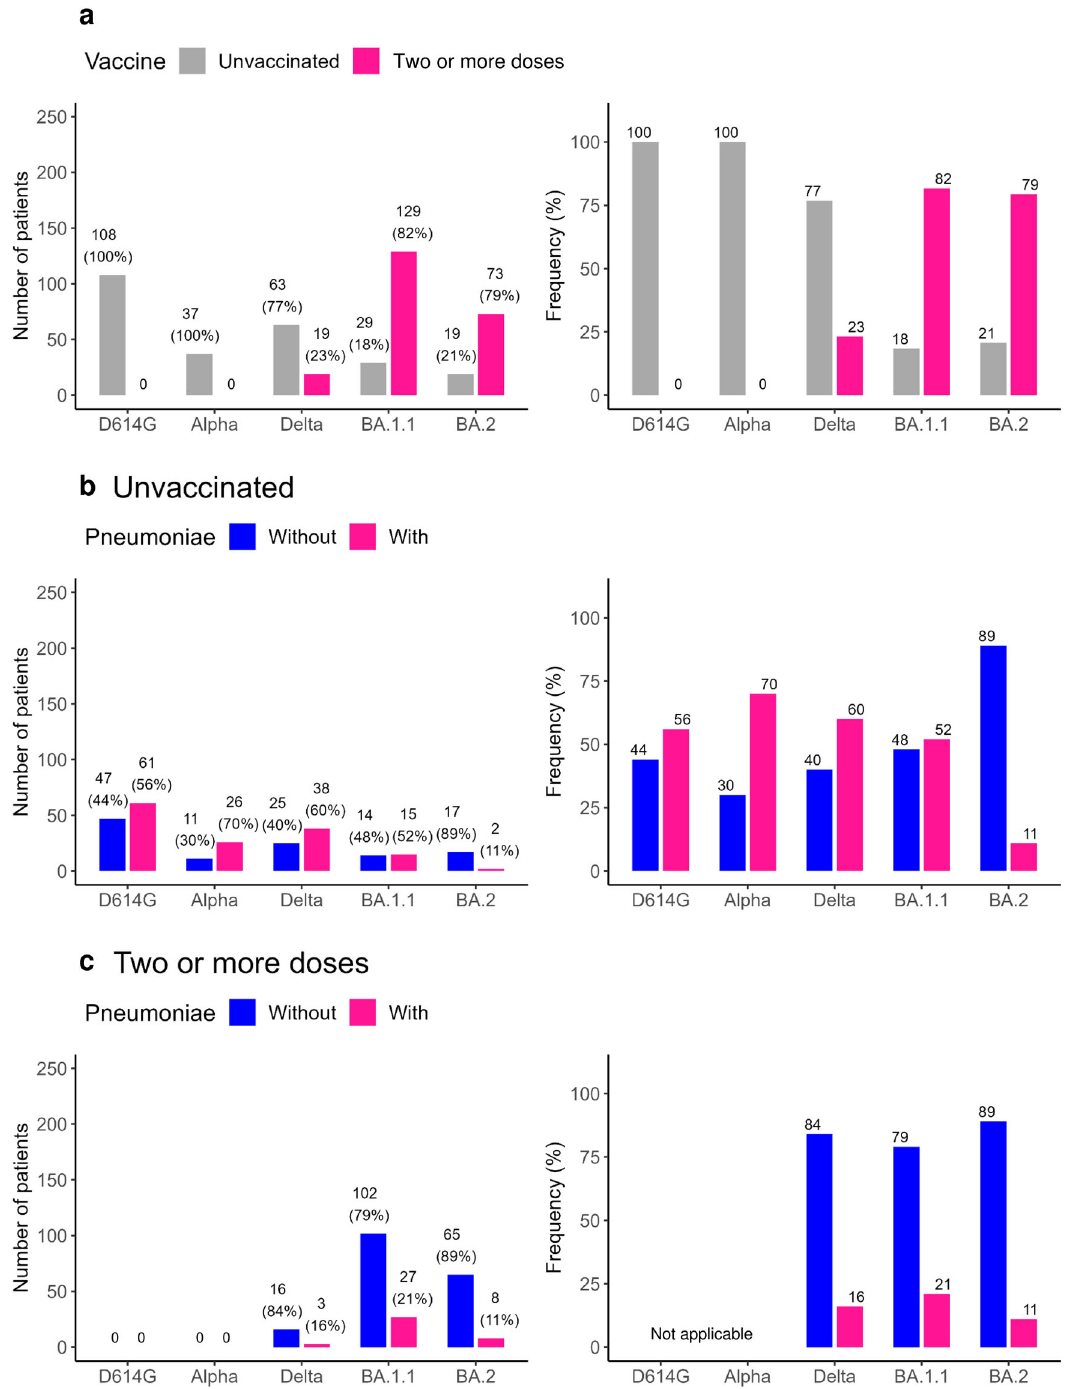
Fig. 2 Vaccination status and pneumonia fi ndings by variant. a Vaccination status by variant. Number of patients (left panel) and percentage of patients (right panel) classi fi ed as unvaccinated or fully vaccinated (i.e., two or more doses). b , c Presence or absence of pneumonia by variant in unvaccinated ( b ) and fully vaccinated patients ( c ). Numbers above bars indicate number of